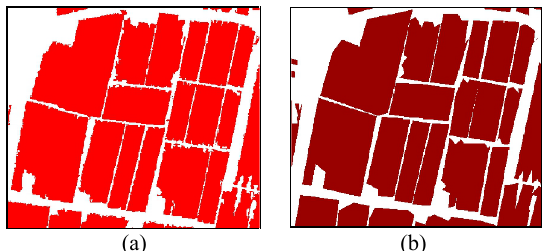
Figure 4. Greenhouse delineation: Greenhouse boundaries after applying boundary tracing (a) and Douglas Peucker line simplification (b)